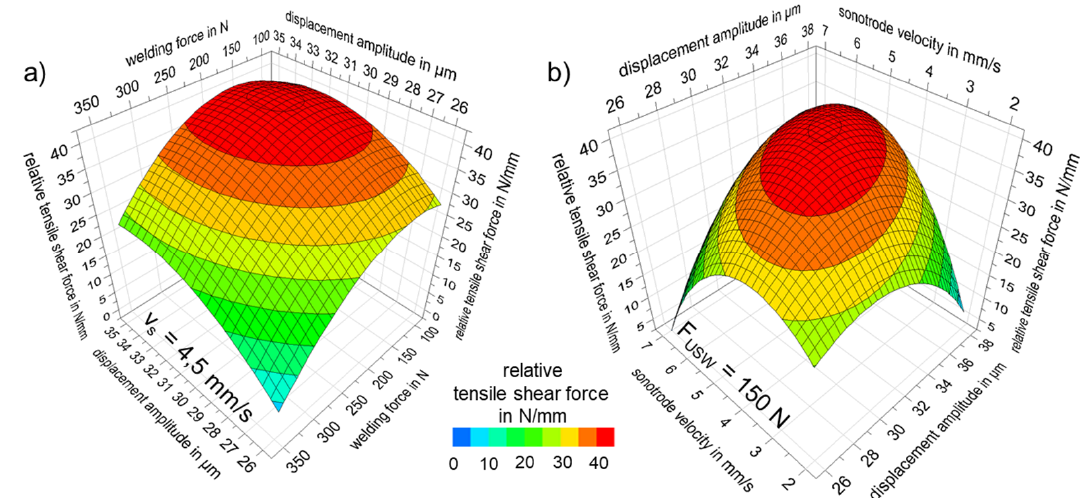
Figure 8. Maximum relative shear force of planar Ti6Al4V/CF-PEEK joints depending on the combination of ( a ) welding force and displacement amplitude for a sonotrode velocity (v S ) of 4.5 mm/s and ( b ) sonotrode velocity and displacement amplitude at a welding force F USW of 150 N.